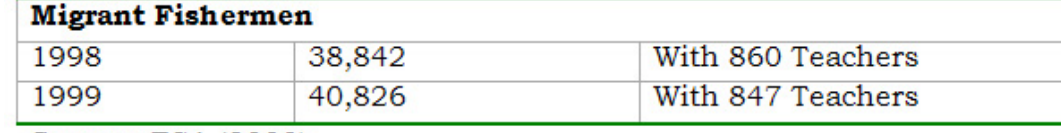
Table 2. Enrolment of Migrant Fishermen,